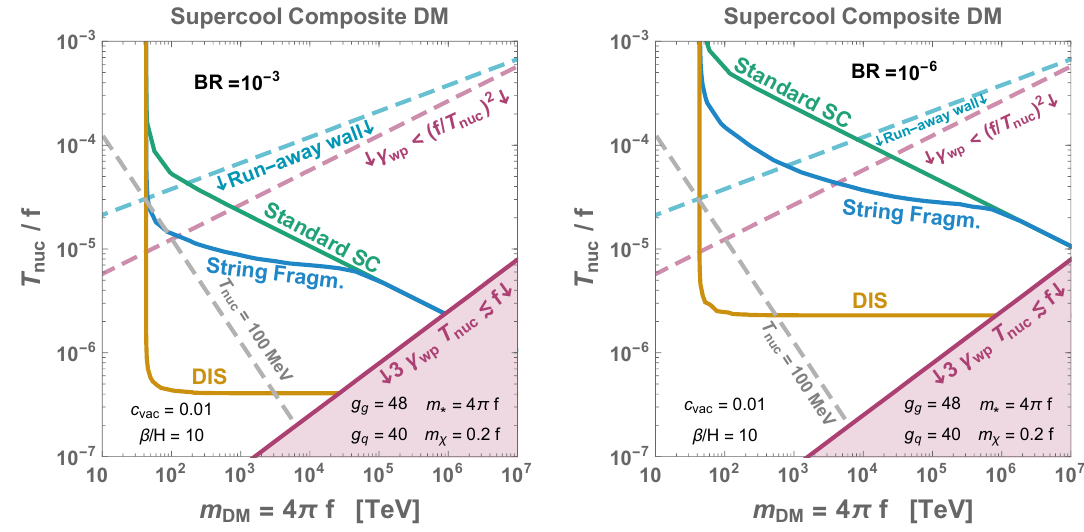
m 4 π f [ TeV ] DM = required to obtain the observed DM Figure 9 . Solid lines: supercooling T nuc /f and DM mass m DM abundance. The parameters chosen imply a reheating temperature T ’ 0 . 13 f , see section 3.2. RH All lines include the thermal contribution discussed in section 9.2. The line with initial condition of eq. (9.1) corresponds to the yellow contour. For comparison, we show in green Y SC +string+ DIS i (blue) the contour that one would obtain by skipping directly from the supercooling (supercooling plus string fragmentation) step to the thermal corrections, respectively eqs. (9.3) and (9.2). All contours converge at some m where thermal effects following reheating become dominant, of the DM order of m . Below this mass, the relic density ≈ 100 TeV because we fixed h σv i = 4 π/m 2 DM rel DM is necessarily suppressed compared to the observed DM density, due to efficient DM annihilation after reheating. In the purple region 3 γ T nuc . f the quarks are reflected by the first wall they wp encounter, but may enter the bubbles in following stages of their evolution, and the DM abundance lines ignore possible modifications arising from this ‘ping-pong’ effect. They also ignore that, for values of γ only slightly larger than f/T and depending on other model-dependent parameters, nuc wp the energetics of our treatment may be more complicated, see eqs. (7.14) and (7.15). The dashed gray line delimits the area T (100) MeV where the supercooled phase transition could happen nuc < O because of QCD dynamics. The dashed light blue line indicates the regimes where bubble walls run away, cf. eq. (5.10). The dashed purple line indicates the regime where γ < ( f/T nuc ) 2 , and the wp fact it lies above the horizontal part of the DIS line confirms that our treatment has been consistent when ignoring the DIS of eq.